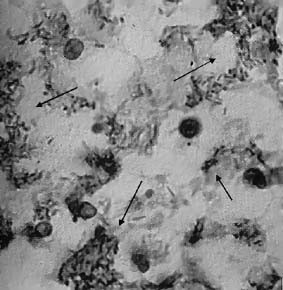
Strains of corynobacterium diphtheriae on a smear. A Giemsa stain (original magnification × 1000) of visceral hemorrhagic necrotic lesions was associated with numerous strains of corynobacterium diphthetiae, producing the typical club-shaped appearance and distributed in a typical Chinese-letter appearance on the smear (arrows).